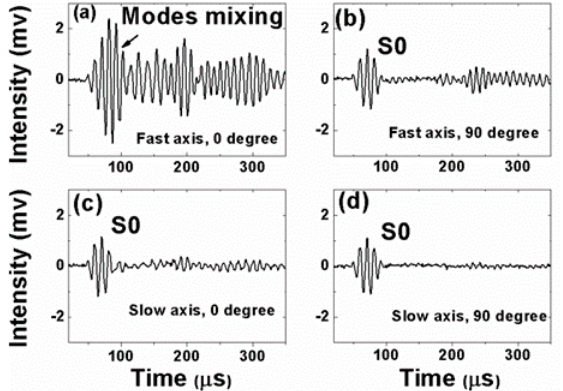
Figure 6. Responses of the Polarization-maintaining Fiber Bragg grating under 60 kHz actuation to ( a ) 0-degree excitation and fast-axis detection; ( b ) 90-degree excitation and fast-axis detection; ( c ) 0-degree excitation and slow-axis detection; and ( d ) 90-degree excitation and slow-axis detection.